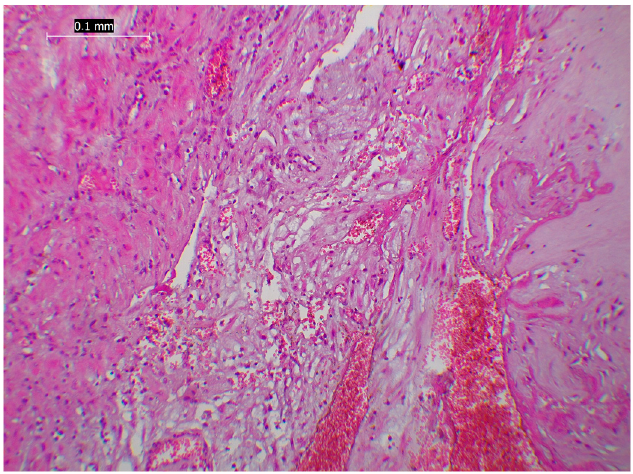
Figure 1. Miometrial-decidual interface, areas of blood suffusion, stromal necrosisa as well as fibroid depositions—Standard Hematoxylin Eosin (HE) Coloration 4×.